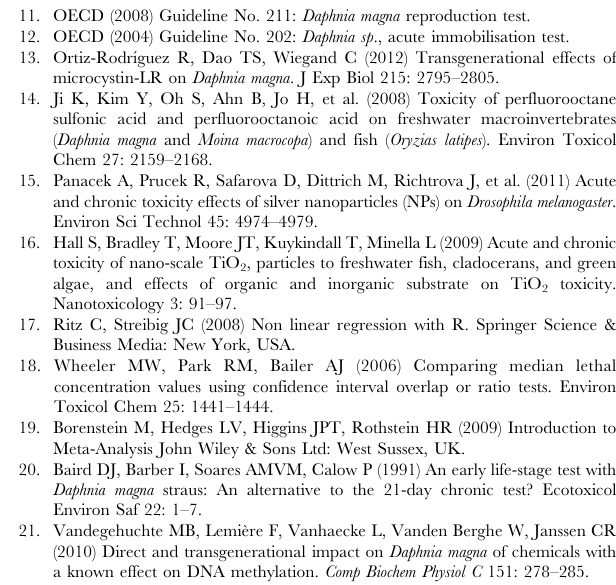
Table S1 Particle characteristics of P25 and A-100: The table displays the 10 th and the 90 th percentile of the particle size distribution, the mean percentage of particles below a particle size of 100 nm as well as the mean particle size together with the polydispersity index. This index provides information on the range of the particle size distribution. A value above 0.3 indicates unreliability of the measurement, due to masking of small particles by large ones. Additionally the zeta potential of the particles and their measured concentration in the test medium is given. nTiO 2 concentrations were measured following Dabrunz et